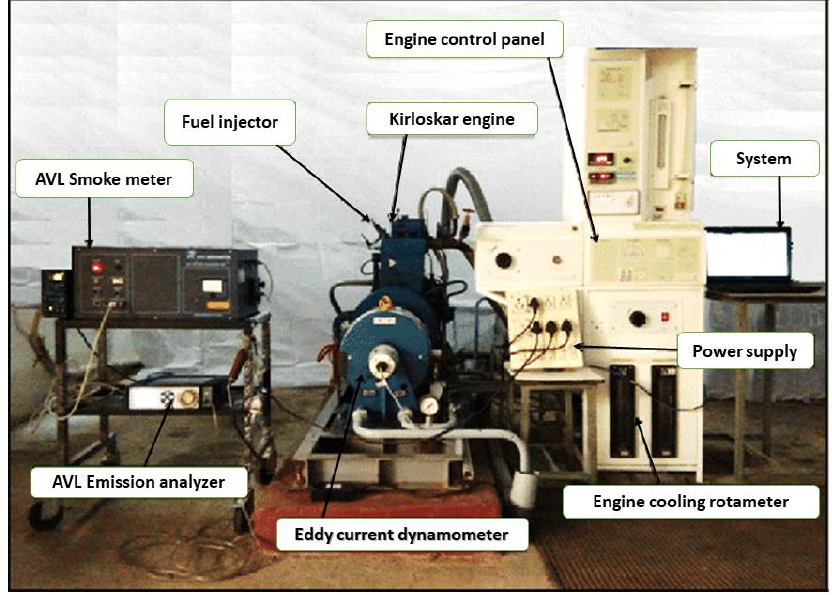
Figure 2. Experimental setup for engine performance and emission measurement.